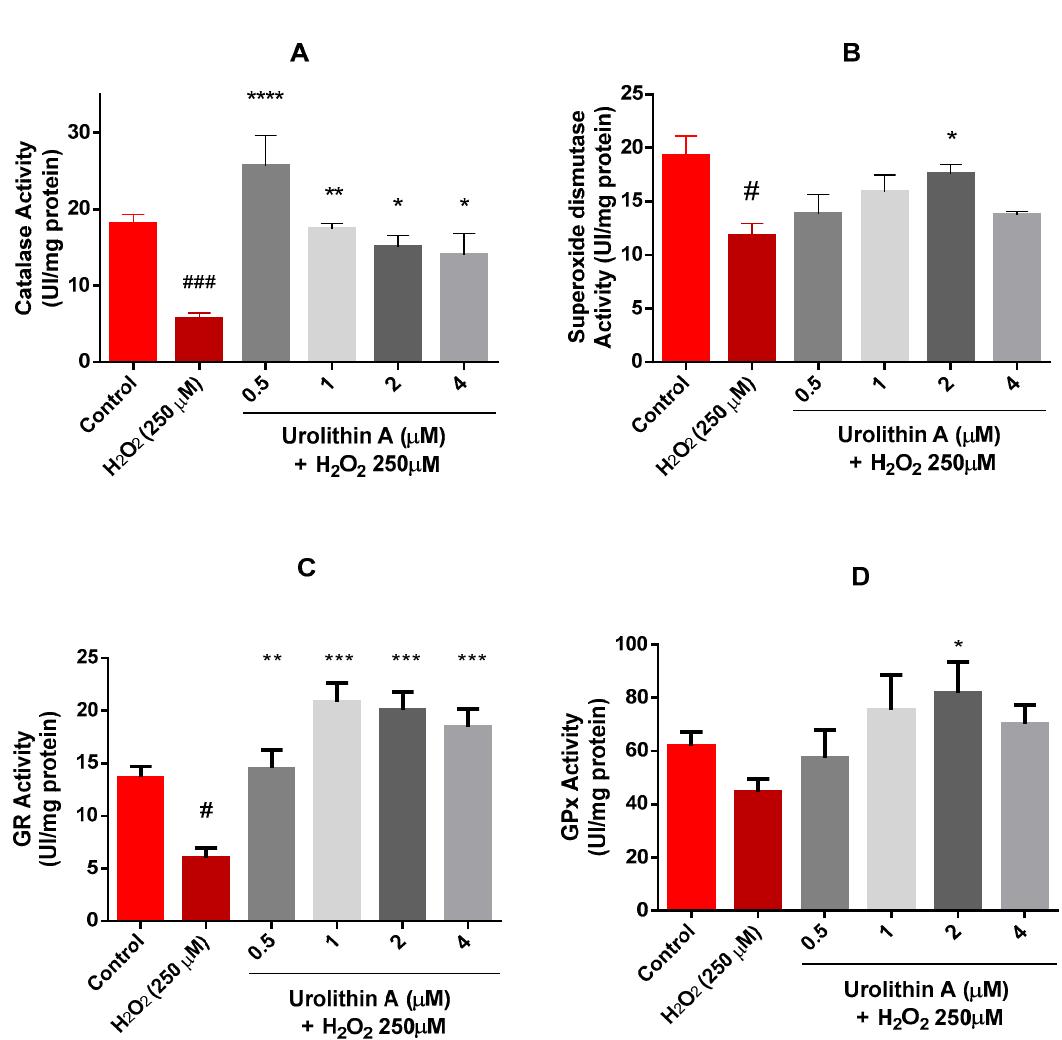
Figure 5. Neuro-2a cell culture redox status. ( A ) Catalase activity. ( B ) Superoxide dismutase activity. ( C ) Glutathione reductase activity. ( D ) Glutathione peroxidase activity. Note: * p < 0.05; ** p < 0.01; *** p < 0.005; **** p < 0.001 versus H 2 O 2 ; # p < 0.05 versus Control; ### p < 0.005 versus Control.